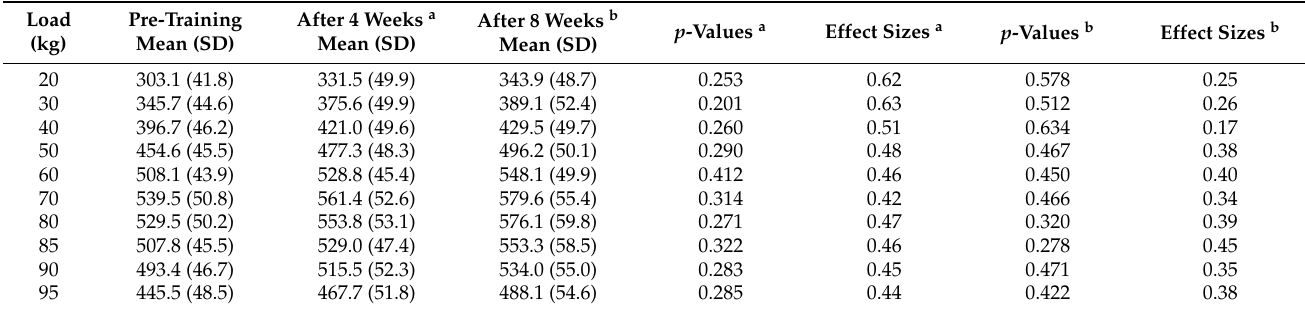
Table 4. Mean power (W) during squats on a stable support base prior to and after 4 and 8 weeks of instability resistance